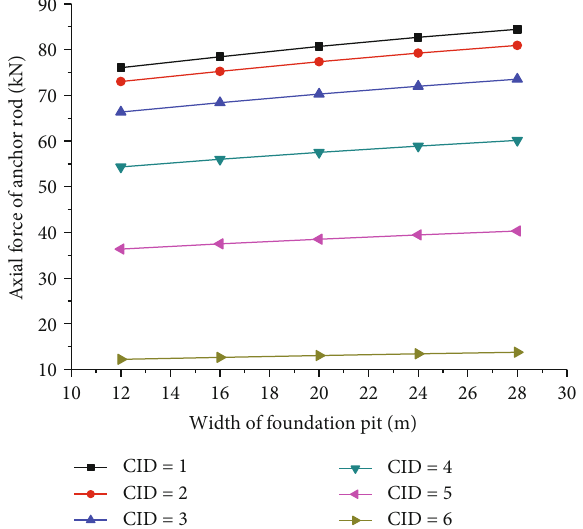
Figure 15: Variation curve of axial force of each member of the leftmost anchor bolt in a deep 10m foundation pit with the width of foundation